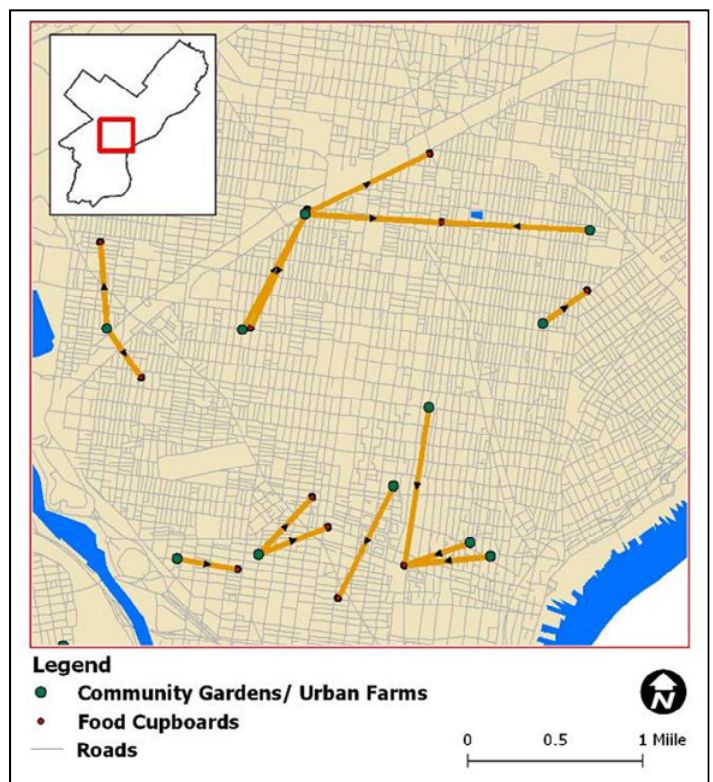
Figure 6. Origin-Destination Network, from Community Gardens or Urban Farms to Food